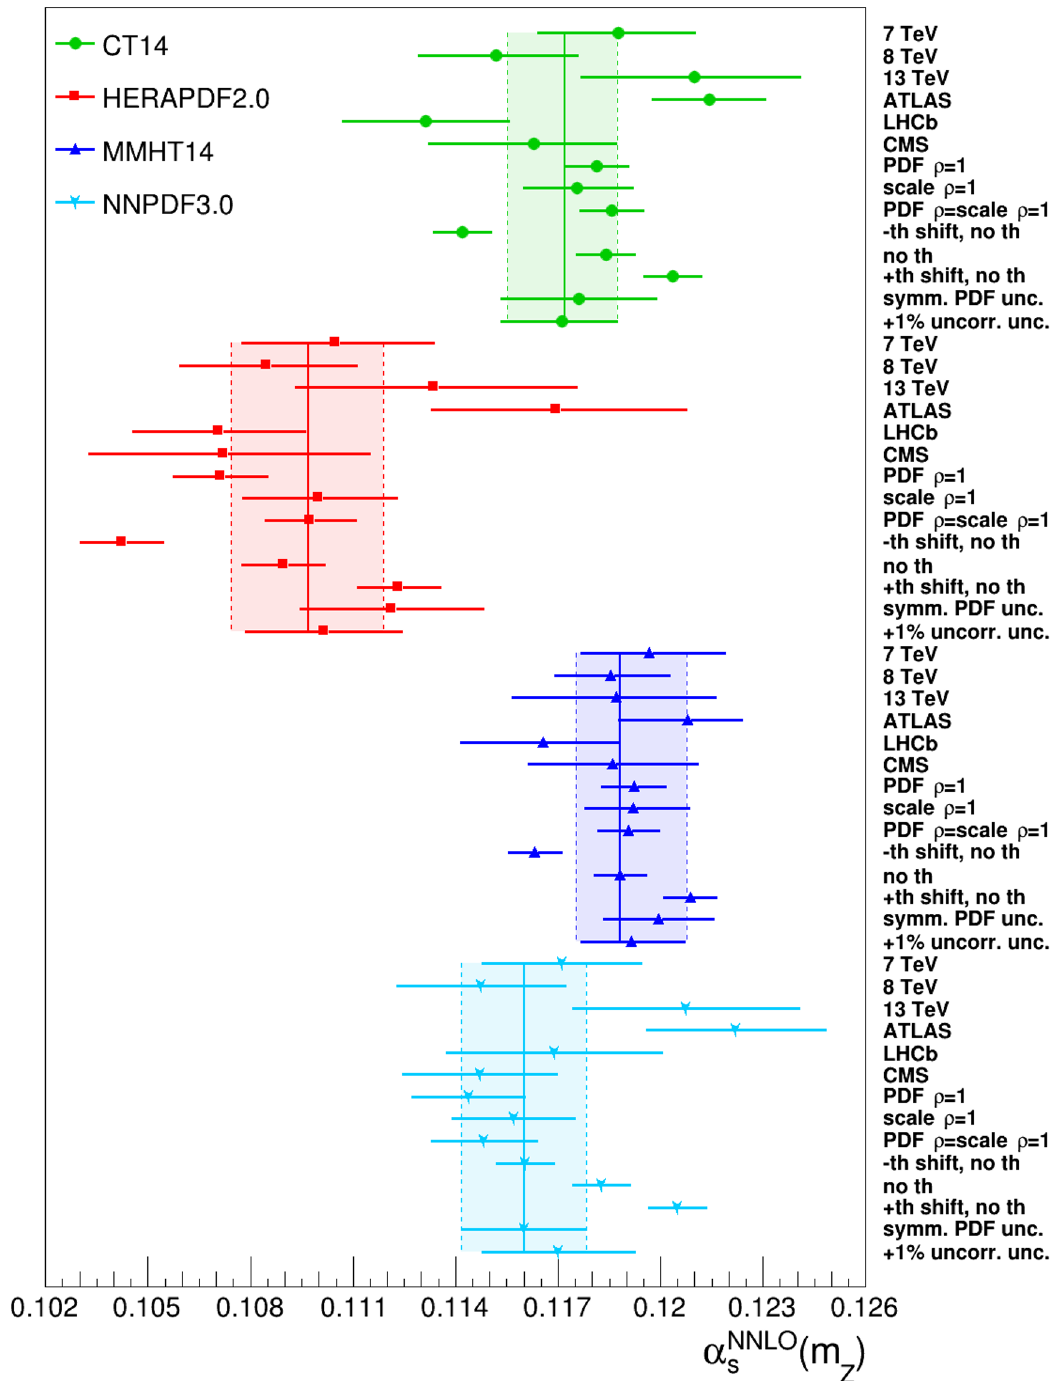
Figure 6 . Sensitivity of the (cid:11) s ( m Z ) values derived per PDF set to the various cross-checks reported in table 14. The di(cid:11)erent symbols with error bars indicate groups of (cid:11) s ( m Z ) values obtained using di(cid:11)erent subsets of the data or varying di(cid:11)erent underlying uncertainties or correlations, individually listed on the right. The shaded areas and vertical lines show the (cid:12)nal results of the default (cid:11) s ( m Z ) extraction per PDF (table 13). The CMS (cid:11) s ( m Z ) values plotted are those derived in [28].